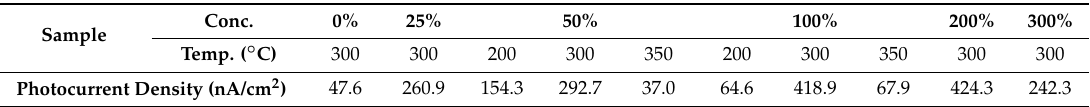
Table 2. Photocurrent density of various photocatalytic C–TiO 2 thin films under visible light. (The calcination temperatures for all unmarked samples 300 °C.)